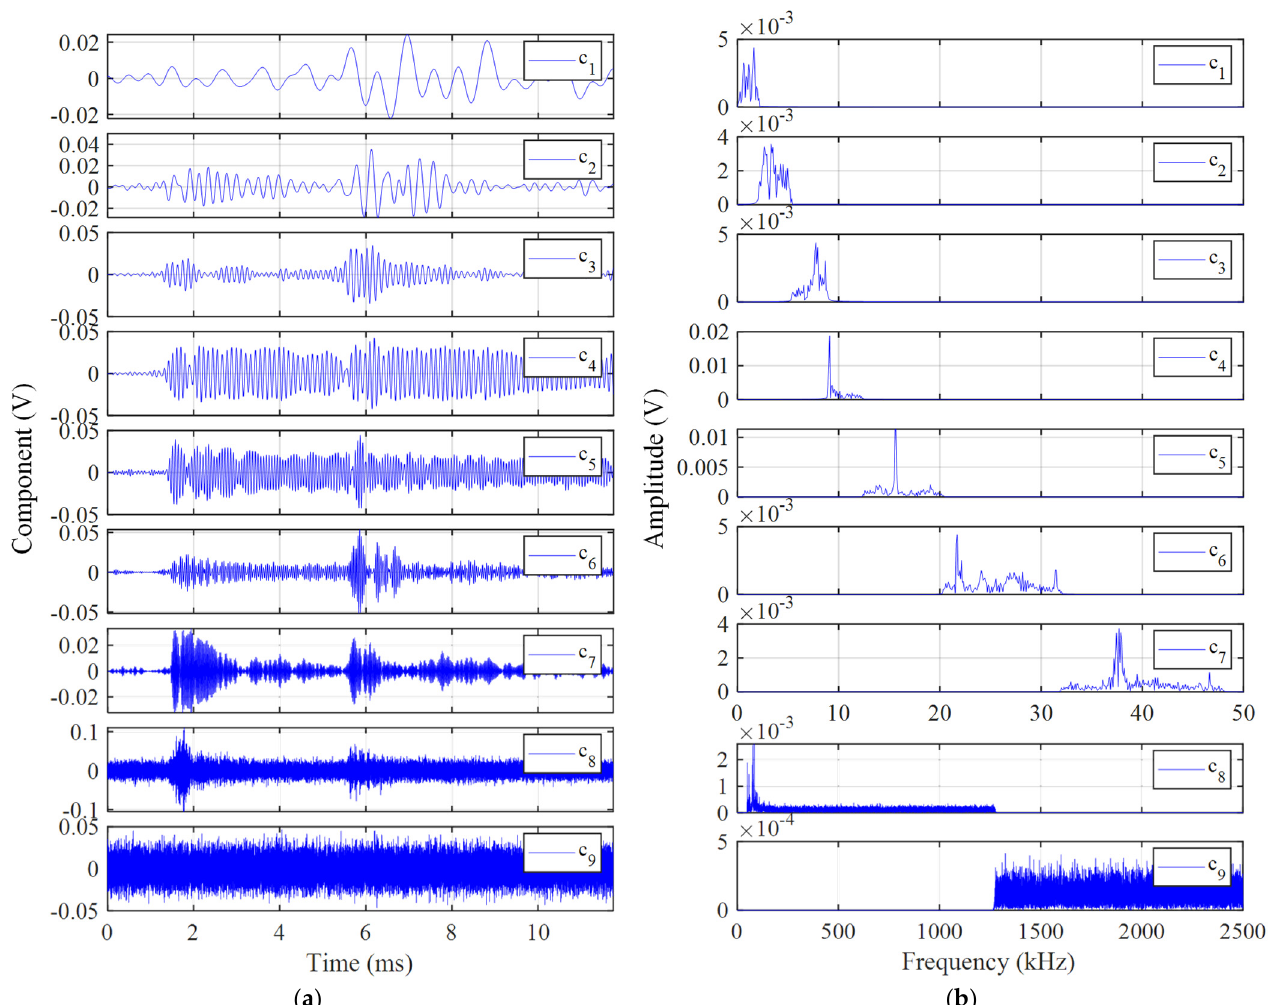
Figure 5. Result of EWT based on DFT and closing operation: ( a ) decomposed components of EMR waveform; ( b ) Fourier spectra of decomposed components.